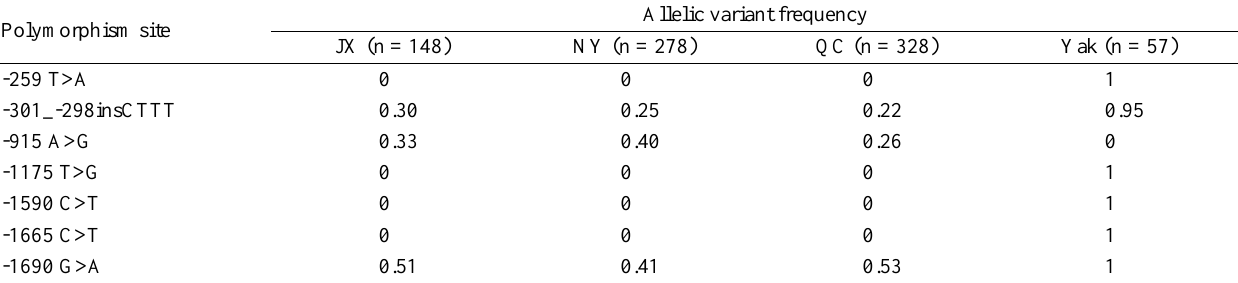
Allelic variant frequency